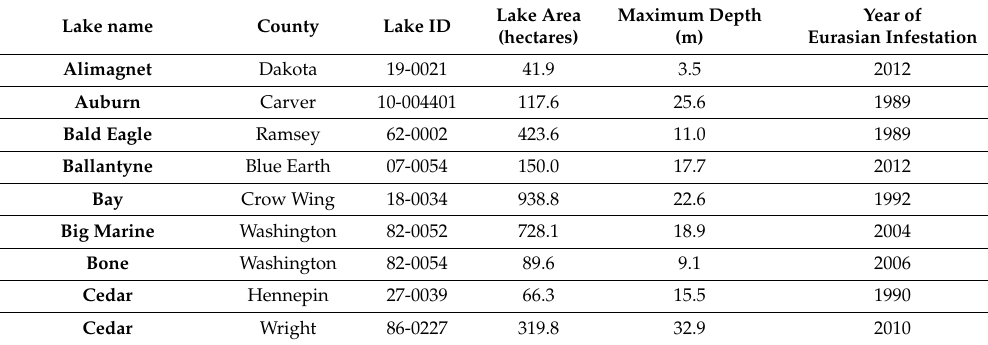
Table A2. Lakes sampled in 2017–2018 including lake area, maximum depth and year of Eurasian infestation for each lake